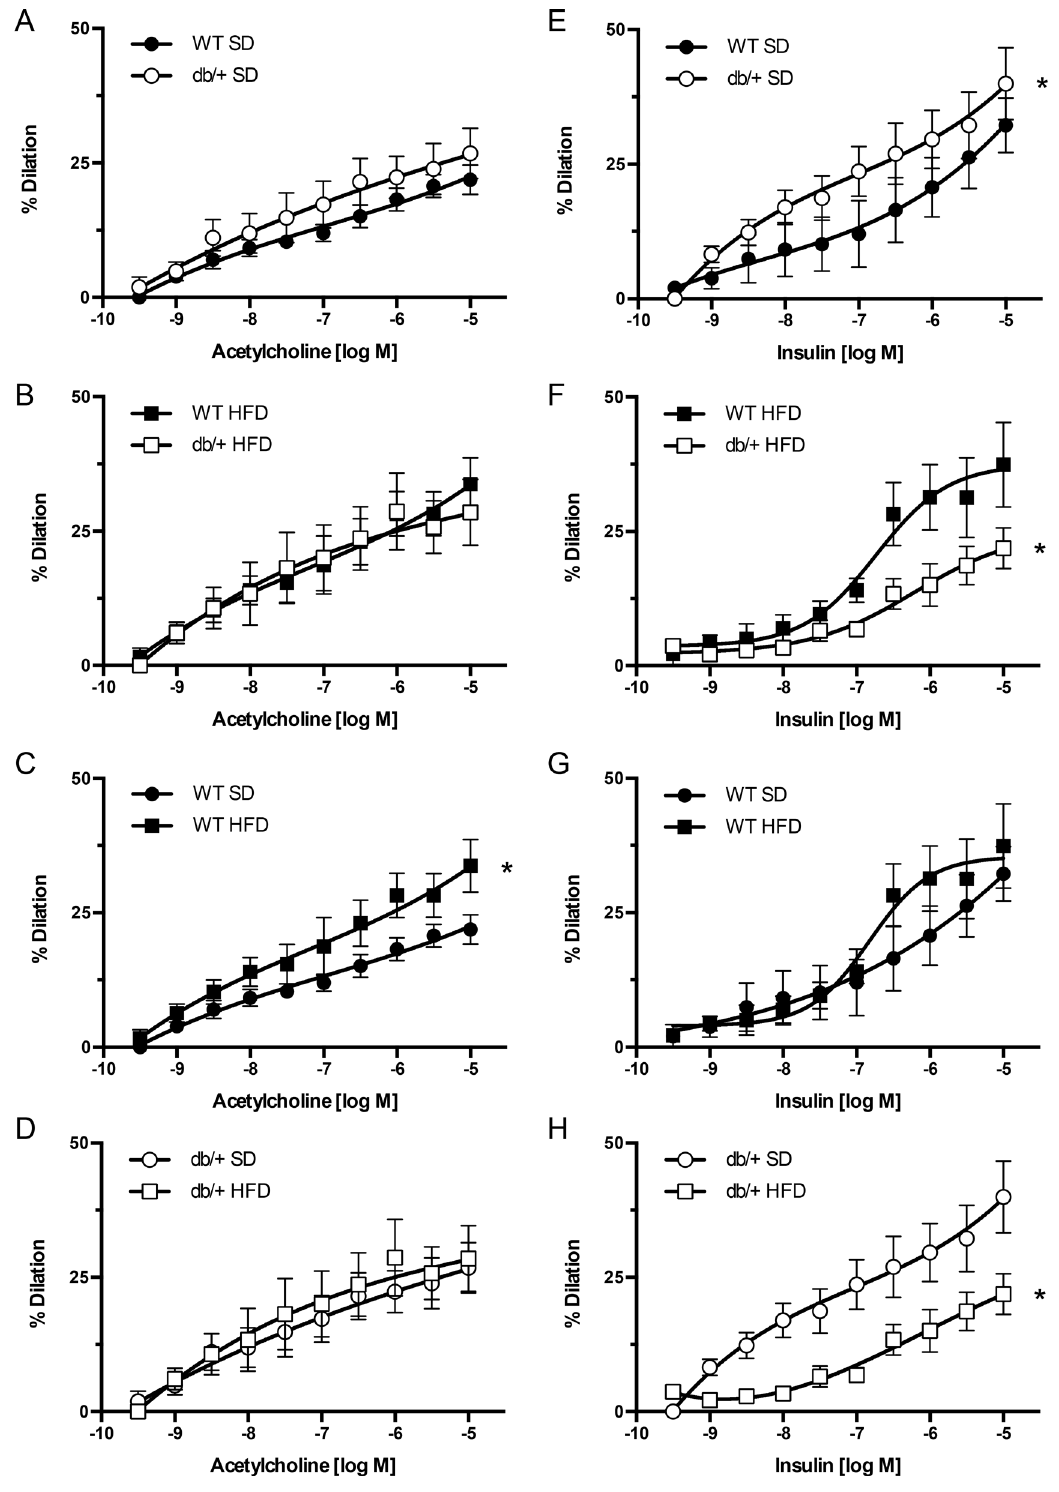
Fig 5. Effect of maternal environment and offspring diet on mesenteric resistance artery responses to acetylcholine and insulin. All blood vessels were obtained from adult (31 week-old) wild type (WT) male offspring of WT-control or Lepr db/+ (db/+) dams. (A-D) Acetylcholine-induced vasodilatory responses. (E-H) Insulin-induced vasodilatory responses. Data are means ± SEM of n = 5 – 6 number of animals (vessels) per treatment group combination. * P < 0.05. SD, standard diet; HFD, high fat